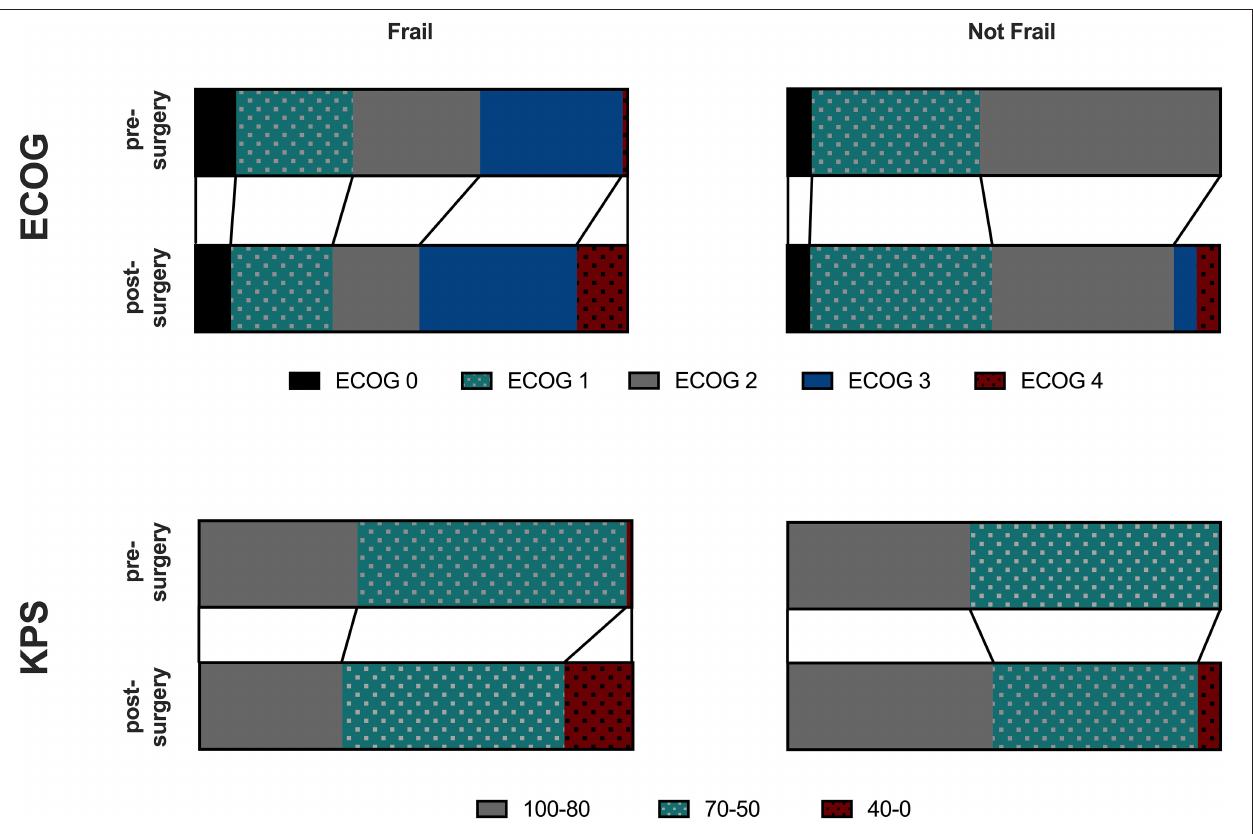
FIGURE 3 | ECOG or KPS was similar in frail and not frail Patients. Those defined as frail had a higher likelihood of developing postsurgical complications and post-operative ECOG status was significantly worse in frail patients using either of the two scales using the G8 ( p < 0.0001), GFI ( p < 0.0001) or a combination of both ( p <